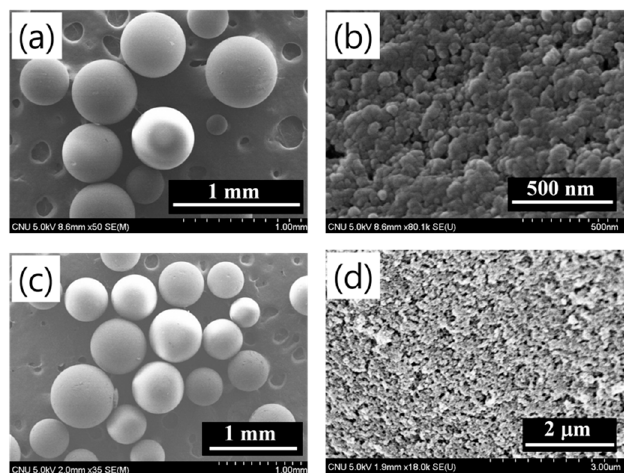
Figure 1. FT-IR spectra of HP20 and HP2MGL.